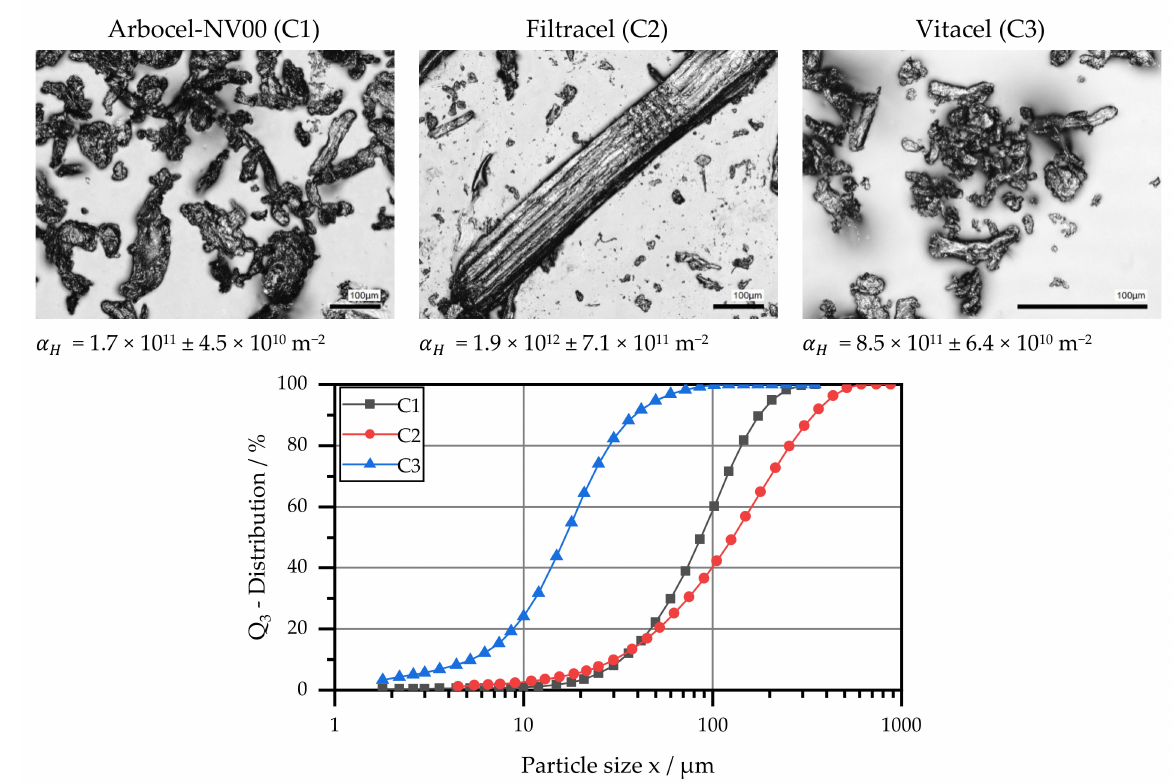
Figure 3. Microscopic image of the investigated filter aids (Cellulose) of J. Rettenmaier & Söhne GmbH + Co KG with fibrous (C1,C2) and orthorhombic (C3) structures, as well as the filter cake resistance and particle size